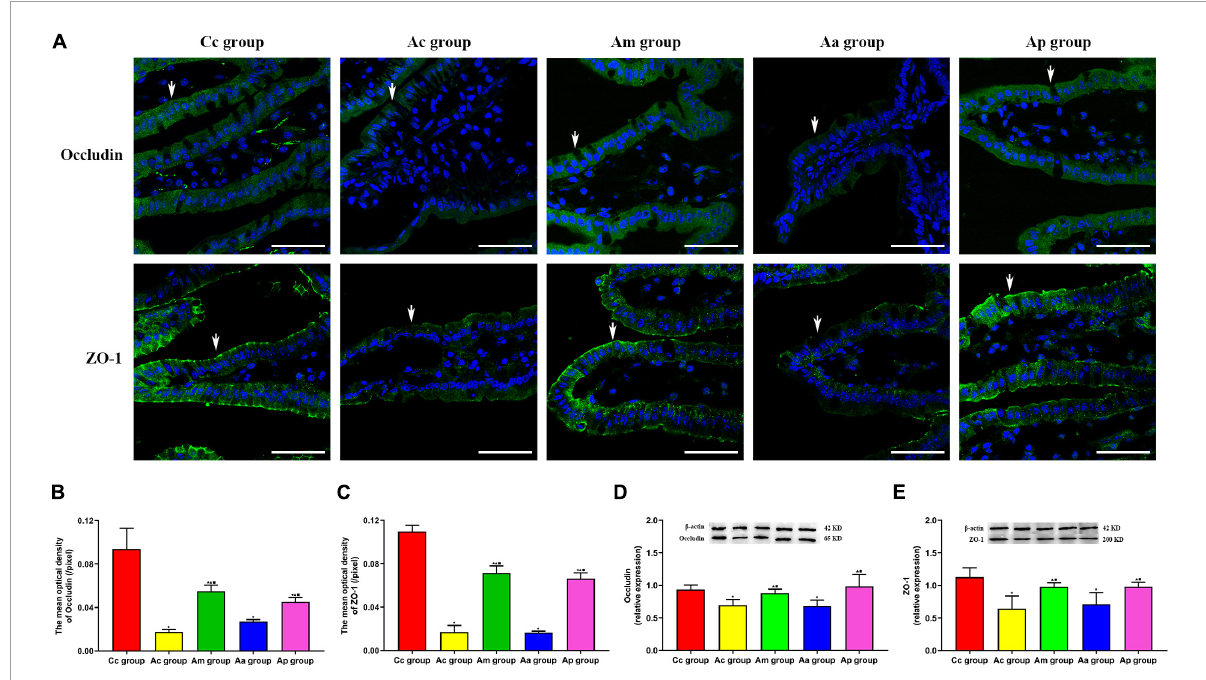
FIGURE4 Results of the expression of intestinal tight junction proteins occludin and ZO-1 in each group ( n = 6, mean ± SD). (A) Representative images of immunofluorescence (IF) staining of occludin (green) and ZO-1 (green) in each group, the positively stained cells are shown with white arrows, and scale bar is 50 µ m. (B,C) Comparison between the mean optical density of occludin and ZO-1 of all groups. (D,E) Comparison between the relative expression of occludin and ZO-1 of all groups. A one-way analysis of variance (ANOVA), followed by the LSD multiple-range test, was used with an exception when comparing the relative expression of ZO-1, which was analyzed by the Kruskal–Wallis test. LSD-t and chi-square are presented in Supplementary Tables 5–7 . (cid:70) P < 0.01 or P < 0.05 compared with the C57BL/6 control (Cc) group, (cid:78) P < 0.01 or P < 0.05 compared with the APP/PS1 control (Ac) group, (cid:4) P < 0.01 or P < 0.05 compared with the APP/PS1 antibiotic + manual acupuncture (Aa)